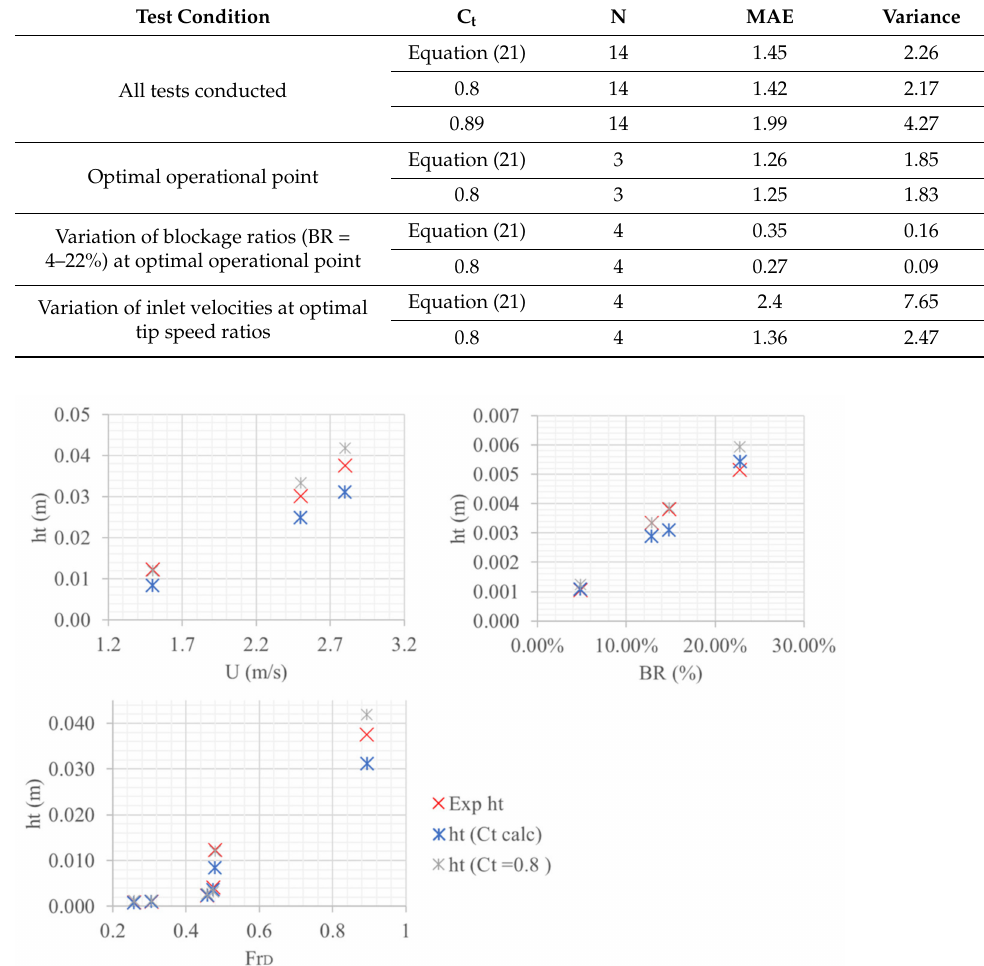
Figure 14. Effects of U , BR , and F rD on the determined h t